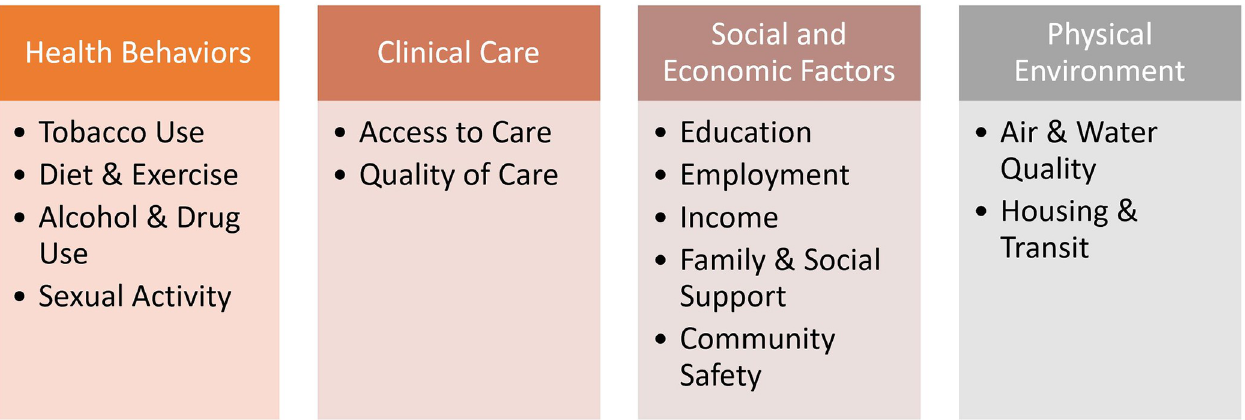
Fig 1. Socio-ecological factors from County Health Rankings & Roadmaps (CHR&R).